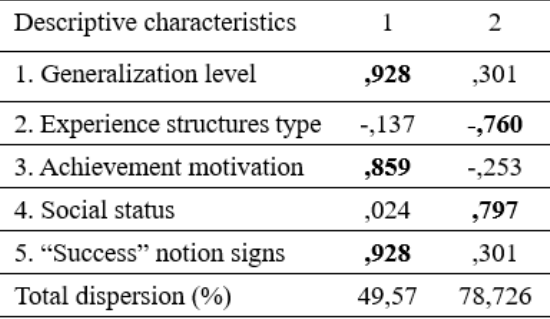
Table 3. Components of the success mental representations factor structures in group